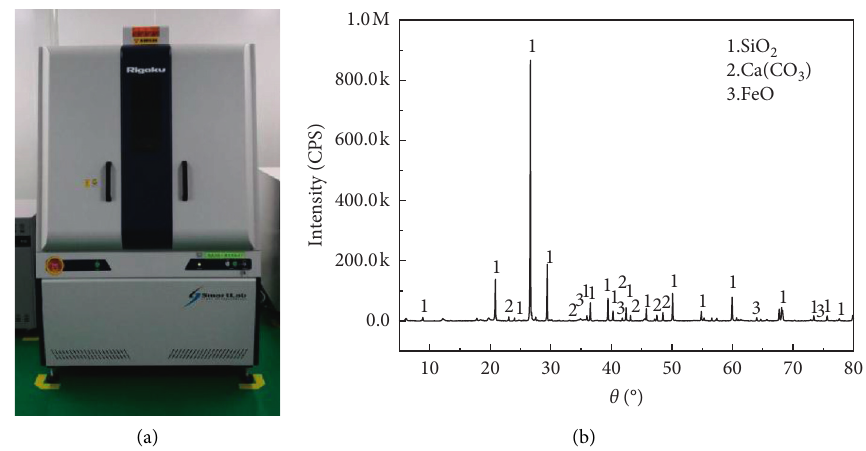
Figure 1: (a) SmartLab 18kW machine; (b) XRD diffraction pattern of the red sandstone samples.